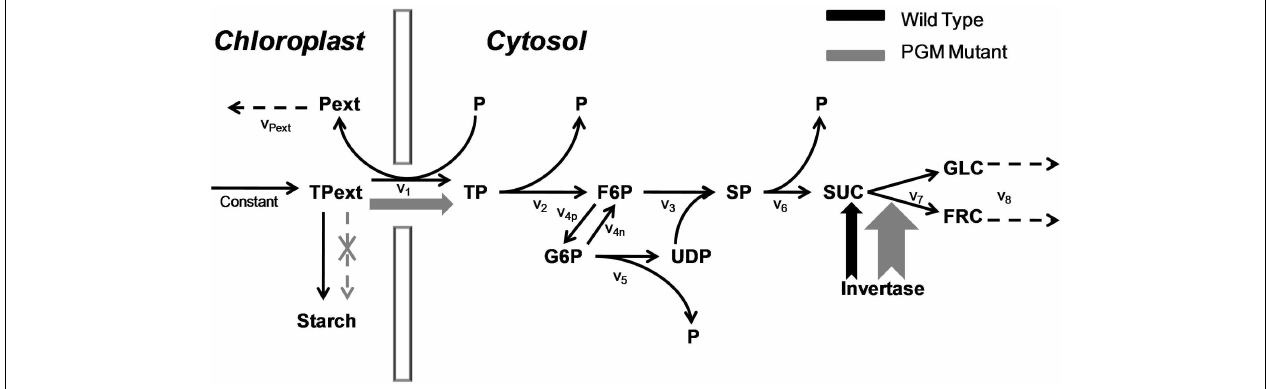
FIGURE 1 | The sucrose synthesis pathway under wild type and PGM mutant . The triose phosphate is imported from the chloroplast to synthesize sucrose in the cytosol. The total amount of triose phosphate in the chloroplast is a constant value. In the wide type, most triose phosphate is used to form the starch; in PGM mutant, the starch synthesis pathway is cut off, which results in a much higher triose phosphate flux into the cytosol; at the same time, the activity of invertase is increased. Both increases are shown in wider arrows in gray. The v 1 , v 2 , etc., are the reaction rates with simple mass action kinetics. Abbreviation: Pext, “external” phosphate in the chloroplast; TPext, “external” triose phosphate in the chloroplast; P, phosphate; TP, triose phosphate; F6P, fructose-6-phosphate; G6P, glucose-6-phosphate; UDP, uridine diphosphoglucose – glucose; SP, sucrose phosphate; SUC, sucrose; GLC, glucose; FRC,